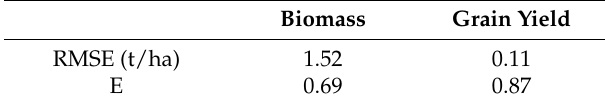
Table 6. Statistical values for evaluating the performance of the AquaCrop model in simulations of final aboveground biomass and grain yield for all the three